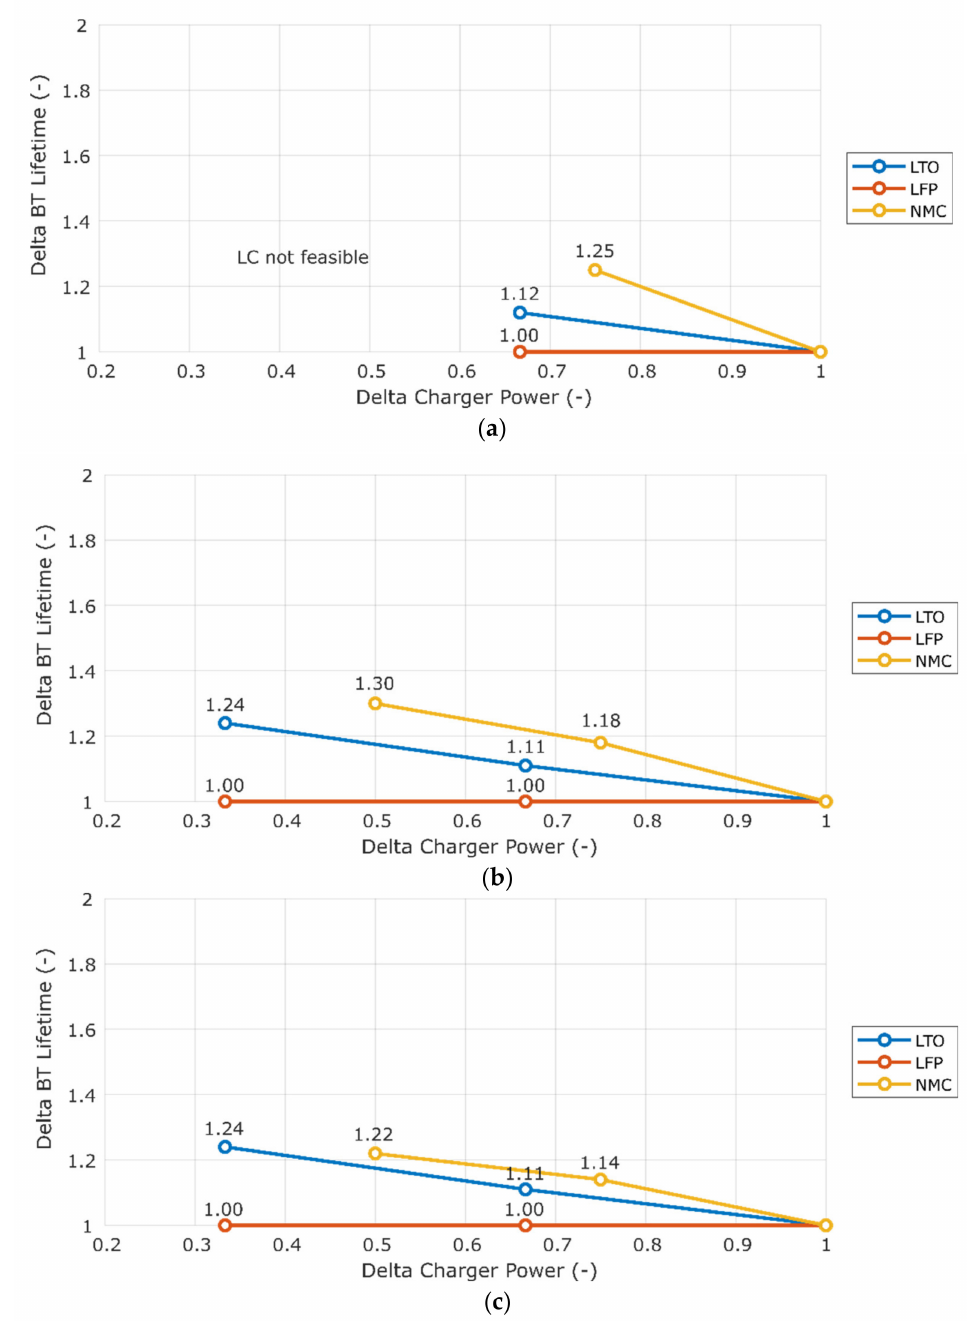
Figure 9. BT life increase/decrease in relation to charger power increase/decrease. ( a ) Barcelona bus line. ( b ) Osnabrück bus line. ( c ) Gothenburg bus